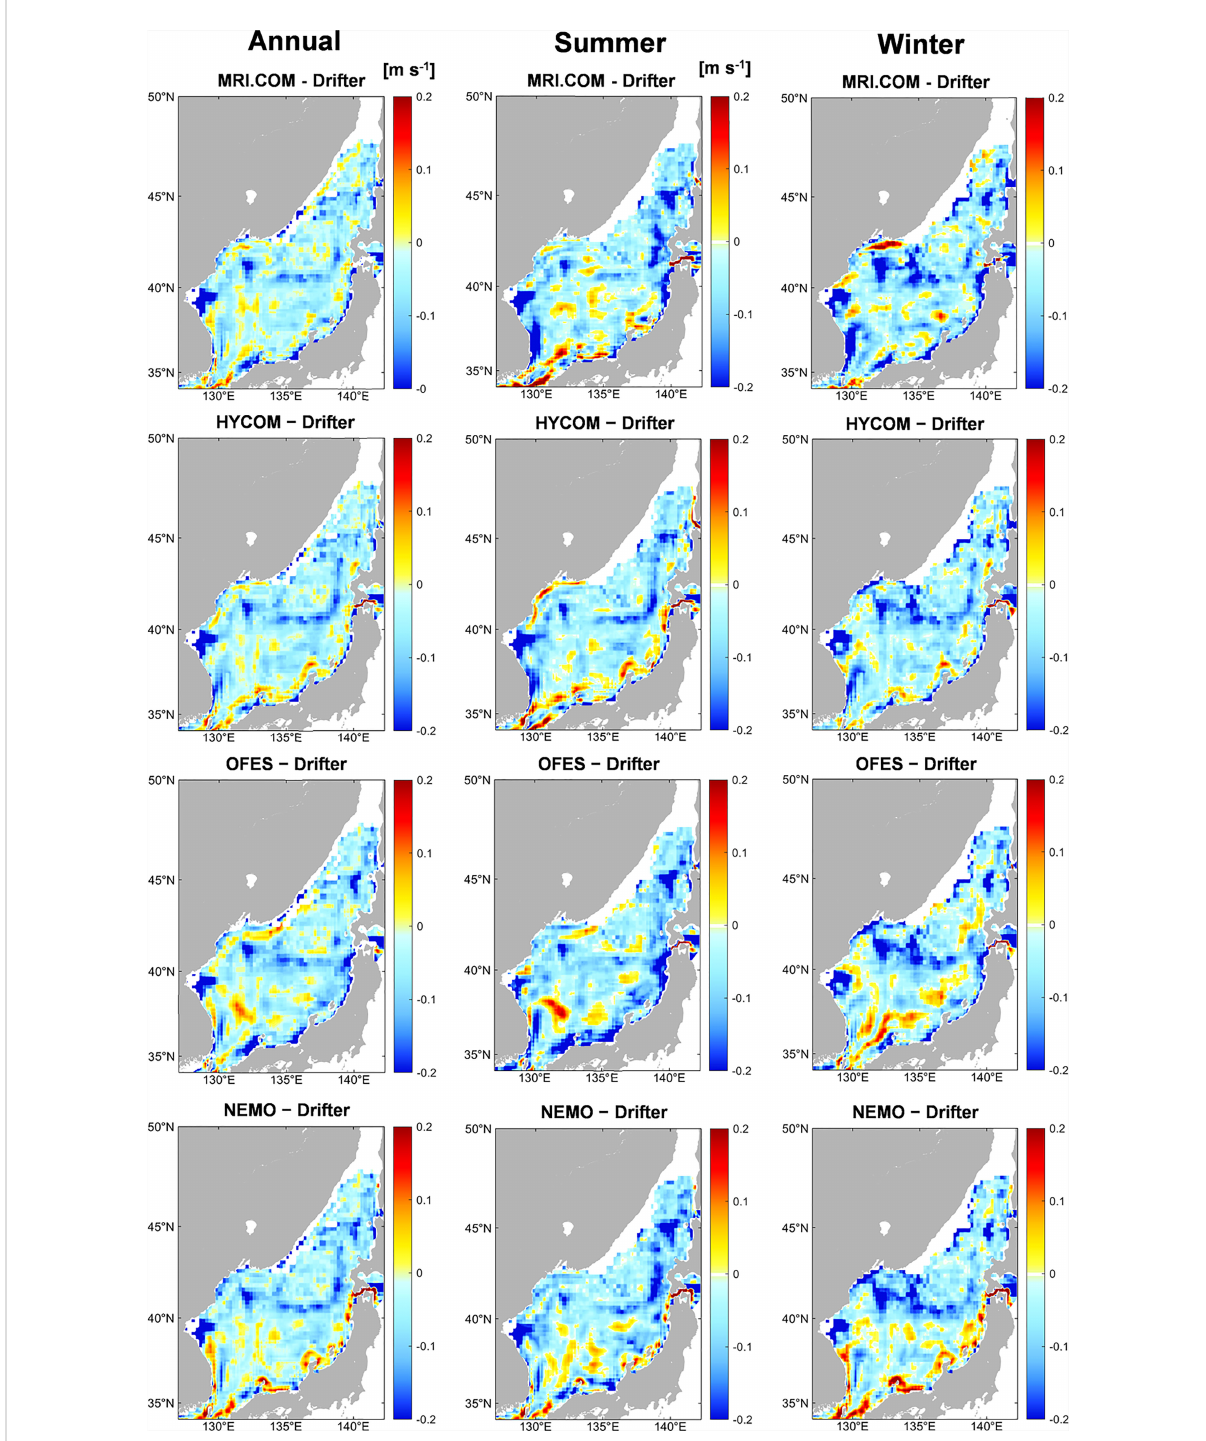
FIGURE 8 Twenty-two – year mean surface velocity at 15 m for the years 1993 through 2014, including the annual mean (left), the summer mean (middle), and the winter mean (right). The panels from top to bottom show the differences of the individual models MRI.COM, HYCOM, OFES, and NEMO from the Drifter reference data,